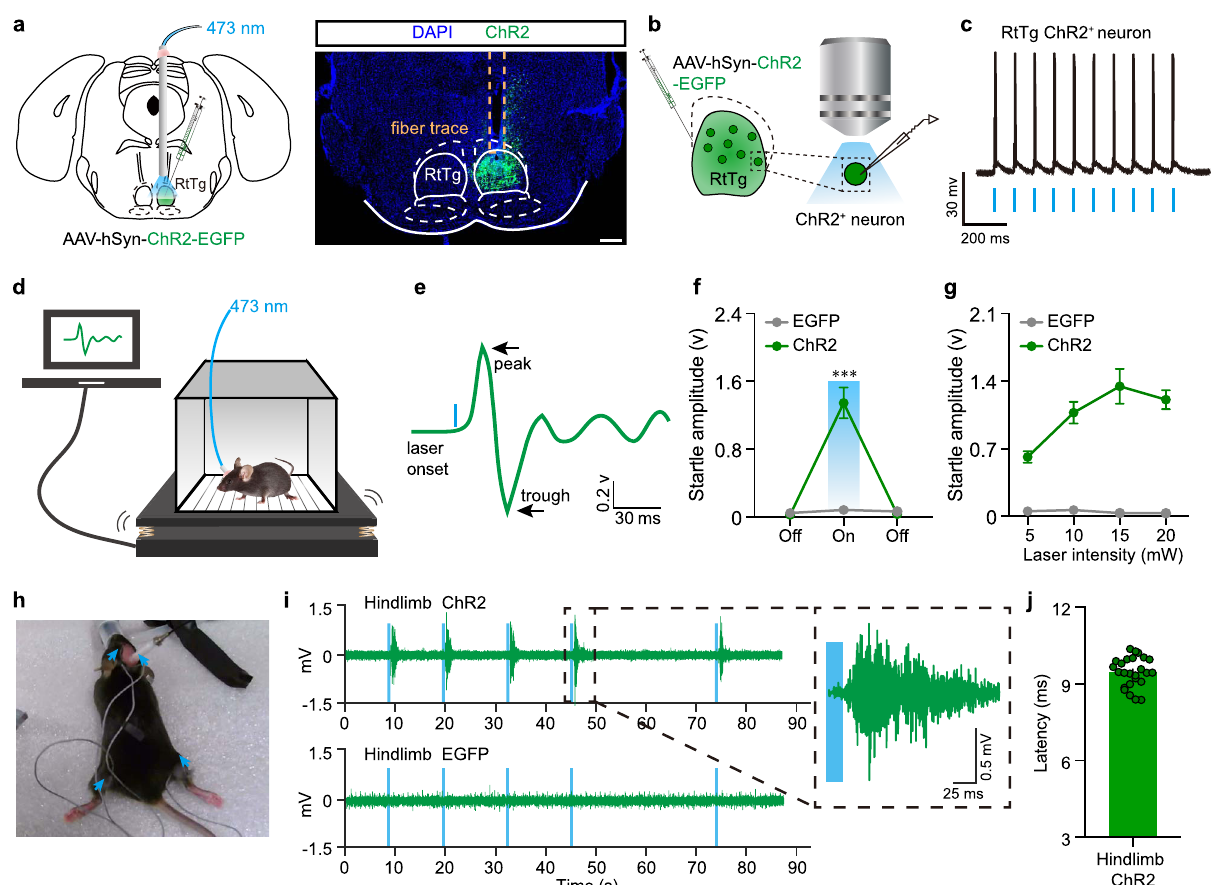
Fig. 1 Optogenetic activation of RtTg leads to stereotypical startle behaviour. a Left: schematic for optogenetic activation of the RtTg. Right: a representative image con fi rming ChR2-EGFP expression in the RtTg, and the optical fi ber trace. Scale bar, 400 μ m. b Schematic for the optogenetic activation and the simultaneous whole-cell patch-clamp recording of RtTg EGFP + neurons in the RtTg brain slice of mice receiving an intra-RtTg injection of the AAV-hSyn-ChR2-EGFP. c Sample traces showing the photostimulation (blue bars, 1 ms)-evoked action potentials in RtTg EGFP + neurons. d Schematic for the optogenetic activation of the RtTg and simultaneous detection of startle re fl exes. e Startle amplitude was de fi ned as the largest peak-to-peak response occurred within 200 ms after the onset of the laser stimulus. f Startle amplitudes evoked by opto-stimulation (blue bars) of the RtTg neurons expressing ChR2 or EGFP ( n = 15 mice per group, two-sided unpaired t-tests, P = 5.78 × 10 − 6 ). g Startle amplitudes at different laser intensities in the ChR2 and EGFP group ( n = 15 mice per group). h Representative image showing the experimental setup for EMG recording during optogenetic activation of RtTg neurons. Blue arrows indicate positions for electrode insertion. i Example of the entire and locally ampli fi ed EMG traces showing activities of mouse hindlimb muscles during optogenetic activation (blue bar) of RtTg neurons. j Quanti fi cation of latency for hindlimb muscle EMG activities after optogenetic activation of the RtTg ( n = 5 mice, 25 bouts in total). Error bar represent mean ± s.e.m. *** P